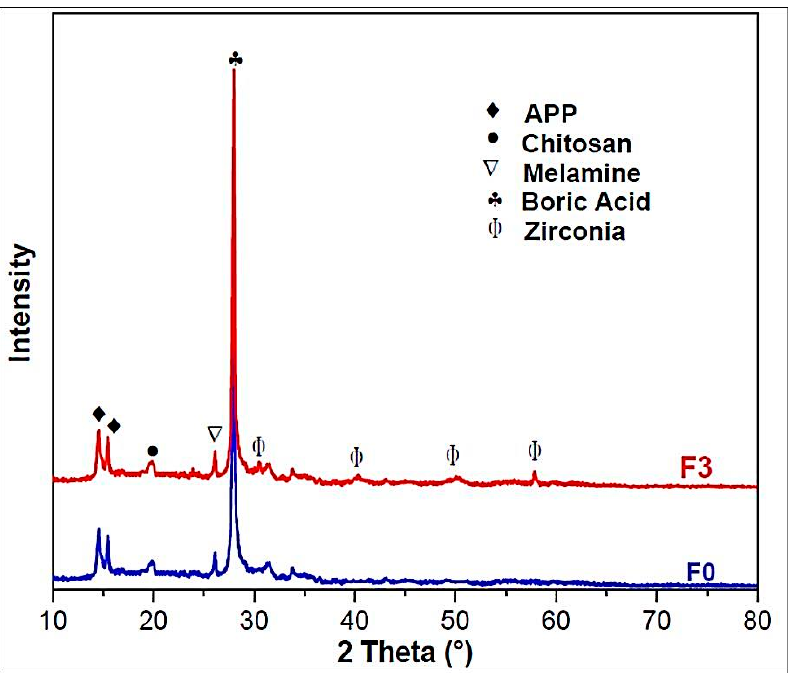
Figure 7. XRD pattern of F0 and F3 samples.